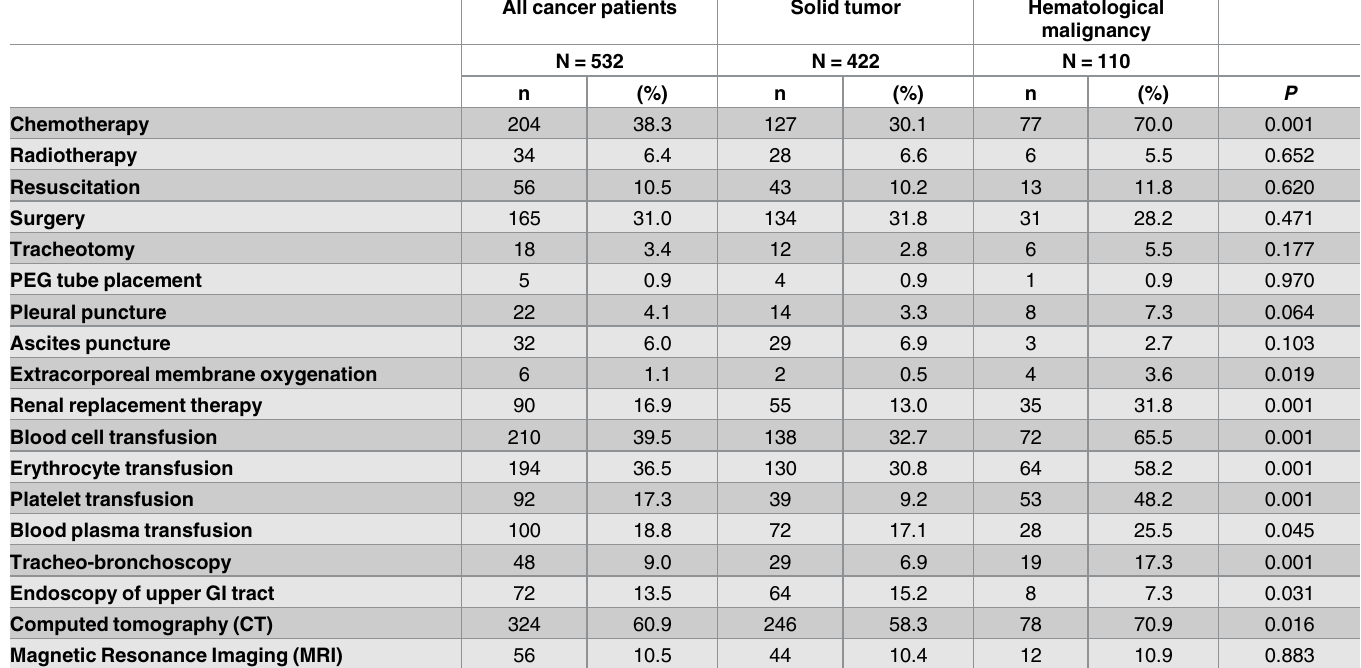
Table 3. Frequencies of medical procedures in cancer patients with malignant solid tumors compared to non-solid tumors in the last month of